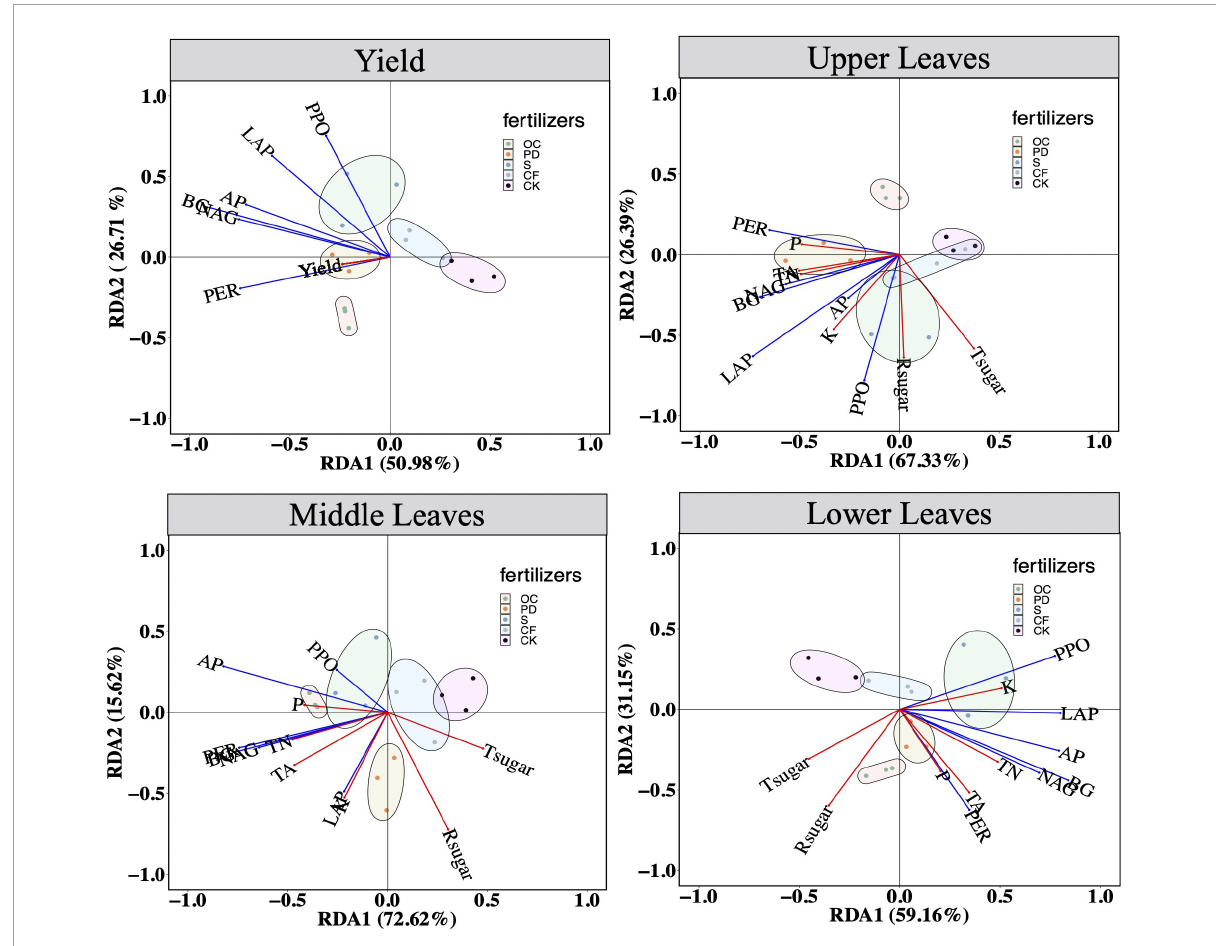
FIGURE3 Redundancy analysis (RDA) of extracellular enzyme activity on yields, and the element levels in the up part, the middle part and lower part of tobacco, respectively, after 12-year tobacco-maize rotation. Tsugar, total sugar in tobacco of corresponding parts; Rsugar, reductive sugar; TA, total alkaloid; TN, total nitrogen; AP, available phosphorus; P, phosphorus; K, potassium; BG, β -1, 4-glucosidase; NAG, β -1,4-N-acetyl-glucosaminidase; LAP, L-leucine aminopeptidase; AP, acid phosphatase; PER, peroxidase; PPO, polyphenol oxidase. OC, oil cake and inorganic nitrogen; PD, pig dung and inorganic nitrogen; S, straw and inorganic nitrogen; CF, inorganic nitrogen; CK, no